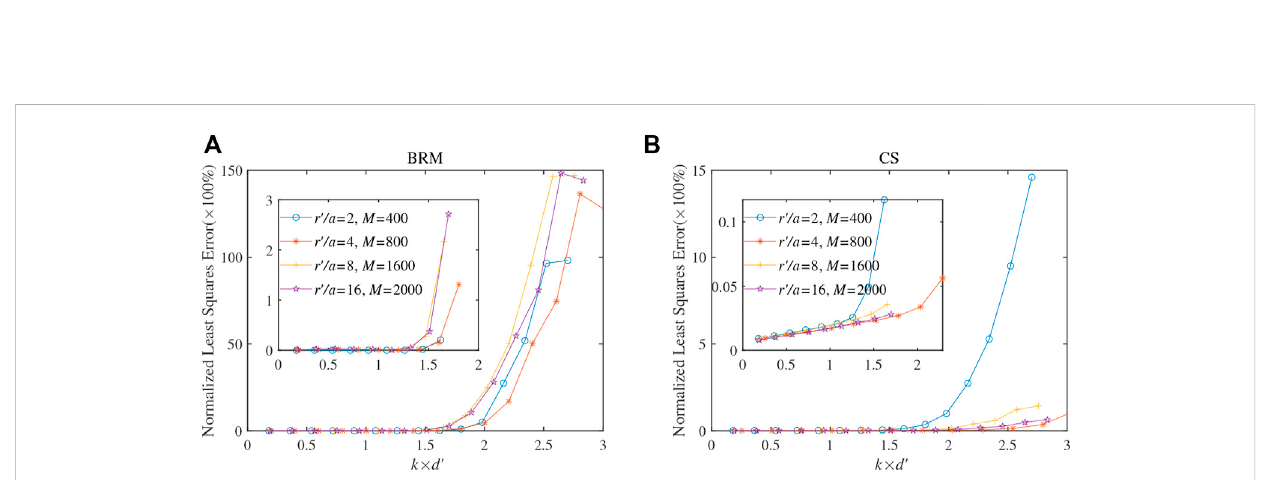
FIGURE 3 The pressure least square errors as a functon of the frequency for different radii of the number of the virtual source at different frequencies. The simulation results of the BRM and CS are shown in (A) and (B) ,